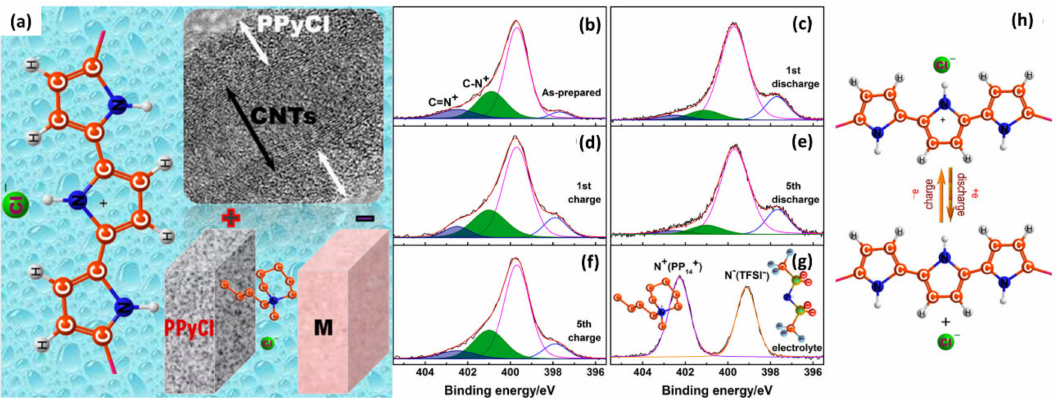
Figure 6. ( a ) Schematic illustration of PPyCl@CNTs cathode (a-g) XPS N(1s) multiplex scan of ( b ) as-prepared PPyCl@CNTs cathodes, and subsequent ( c ) first discharge and ( d ) first charge, ( e ) fifth discharge and ( f ) fifth charge, and ( g ) the electrolyte itself. ( h ) The charge / discharge mechanism in the portion of PPyCl. (Reproduced with permission from Reference [35]; Copyright (2017) American Chemical